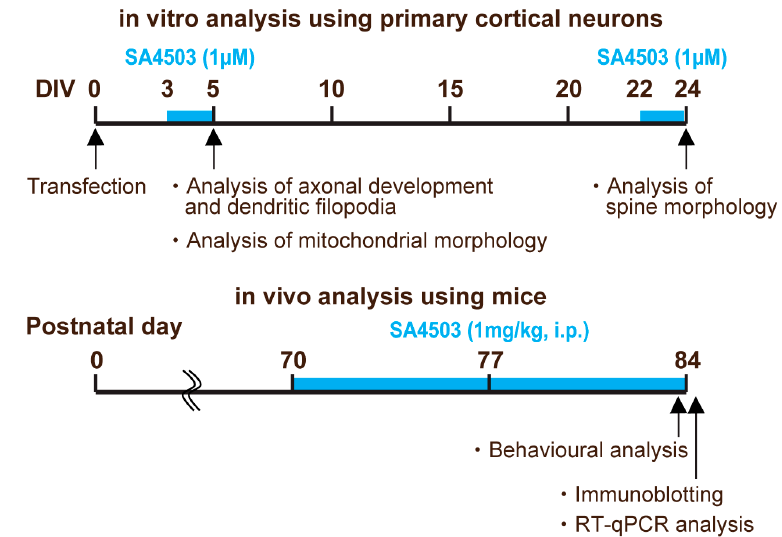
Figure 5. Diagrams of the experimental schedule. In in vitro analysis using primary cortical neurons, SA4503 (1 µ M, dissolved in distilled water) was treated for 48 h in cultured cortical neurons in both DIV5 and DIV24. In in vivo analysis using mice, we administered SA4503 over the course of two weeks (1 mg/kg, intraperitoneally (i.p.) daily from postnatal day (P) 70 to P84) to Atrx ∆ E2 mice and subsequently assessed memory-related behaviors and biological